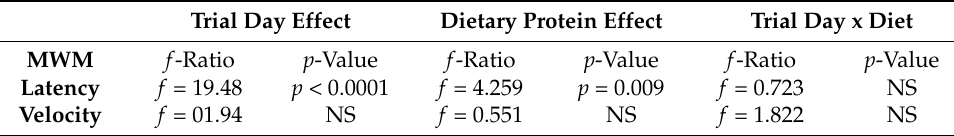
Morris Water Maze (MWM) performance corresponding to the mean area-under-curve calculations of latencies to locate and land on the platform and swim velocities were compared over 4 consecutive trial days by two-way ANOVA. Since gender differences were not significant, male and female data were combined. f -Ratios correspond to Trial Day effects, dietary protein + ethanol exposure effects, and Trial Day x exposure interactive effects. NS = not significant. Graphs and post hoc Tukey test results are shown in Figure